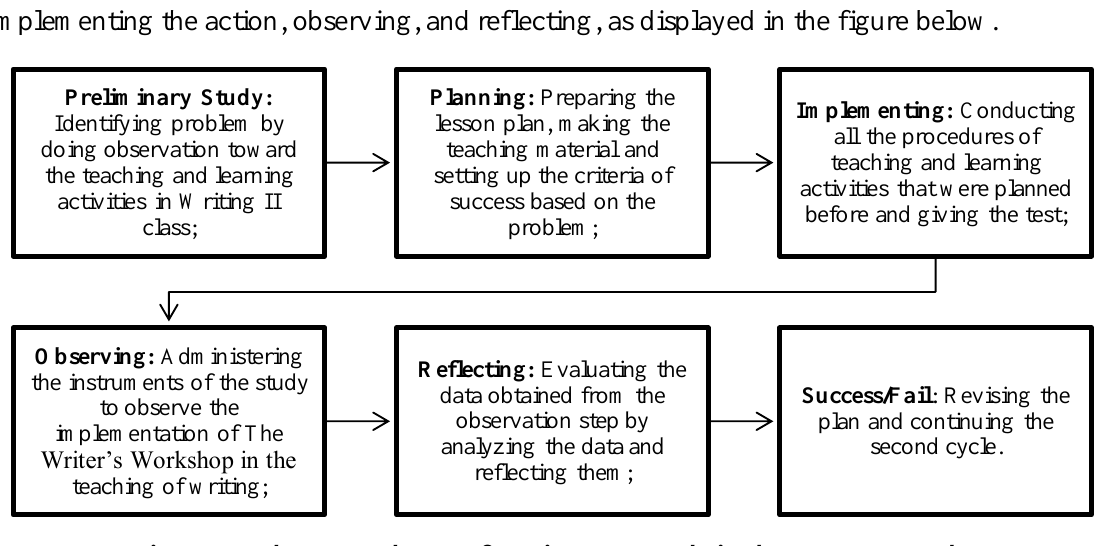
Figure 1: The Procedures of Action Research in the Present